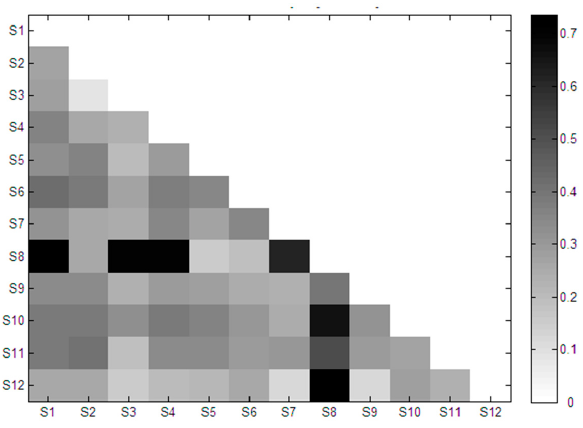
Figure 4. The heat-map of osteoclastic inhibitory activities of paired Herba epimedii samples. S1–S12, mean sample 1–sample 12 of Herba epimedii .